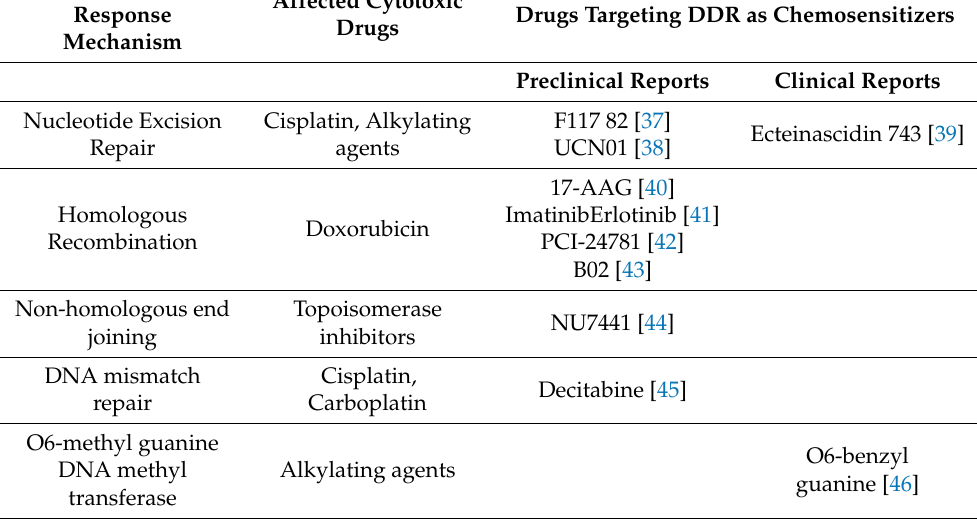
Table 2. DNA damage response pathway in MDR and their inhibitors as